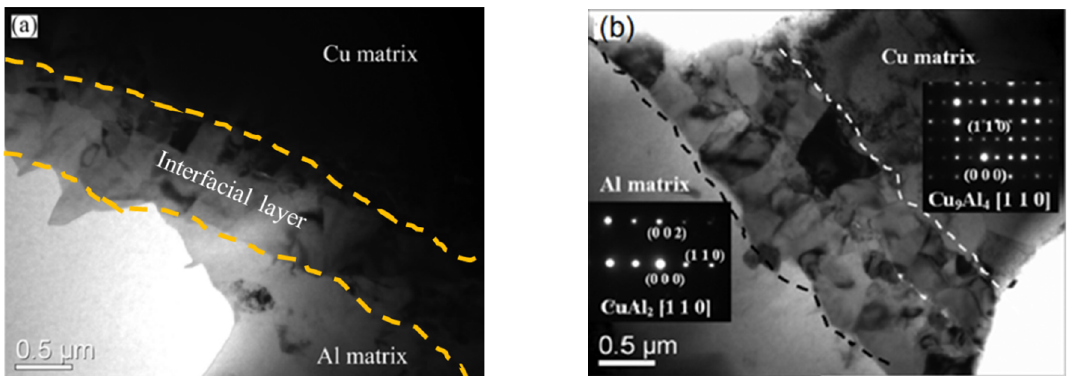
Figure 6. ( a ) Tight formation of bonding interface after cold rolling, and ( b ) atomic diffusion and intermetallic formation at the interface after annealing at 300 °C. Reproduced with permission from Ref. [63].